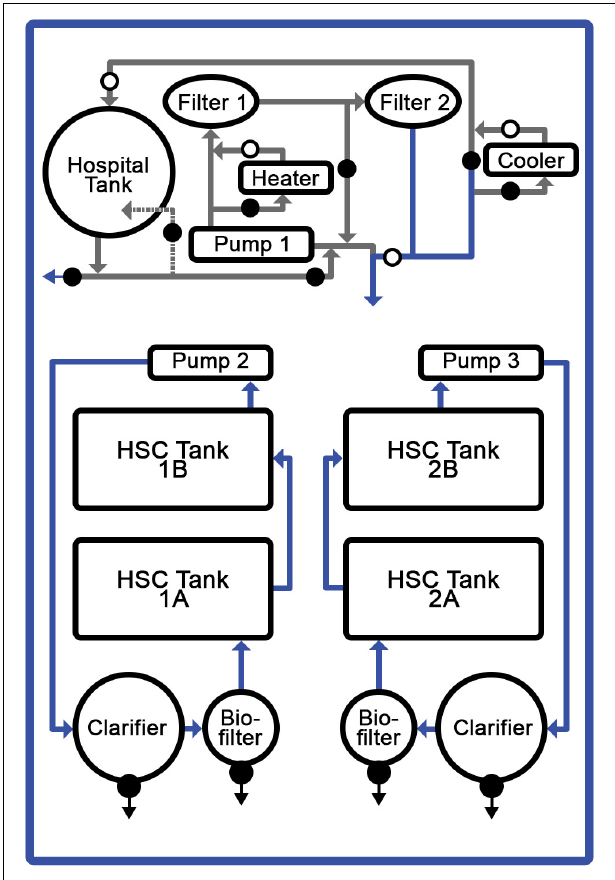
FIGURE 1 | Recirculating aquaculture system (RAS). Temperature-controlled, saltwater system optimized for HSC comprising: four discrete tanks, filtration units, and aeration system. Respective feed formulations were provided to specific tanks with 6 HSCs